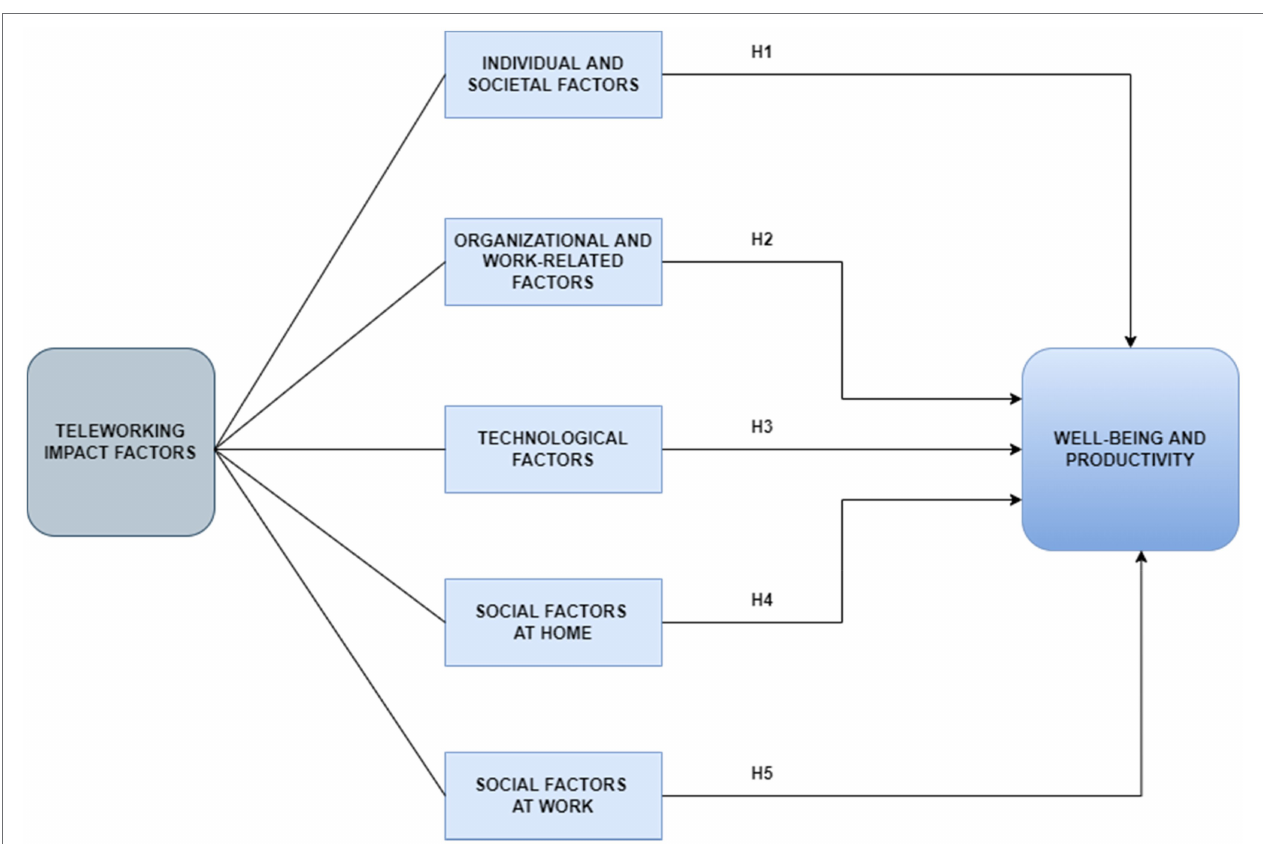
FIGURE 1 | Research